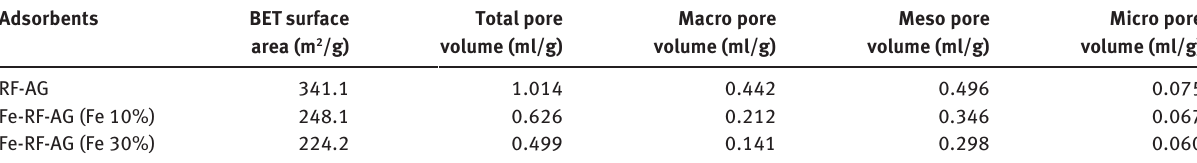
Table 2 BET area and pore volumes of